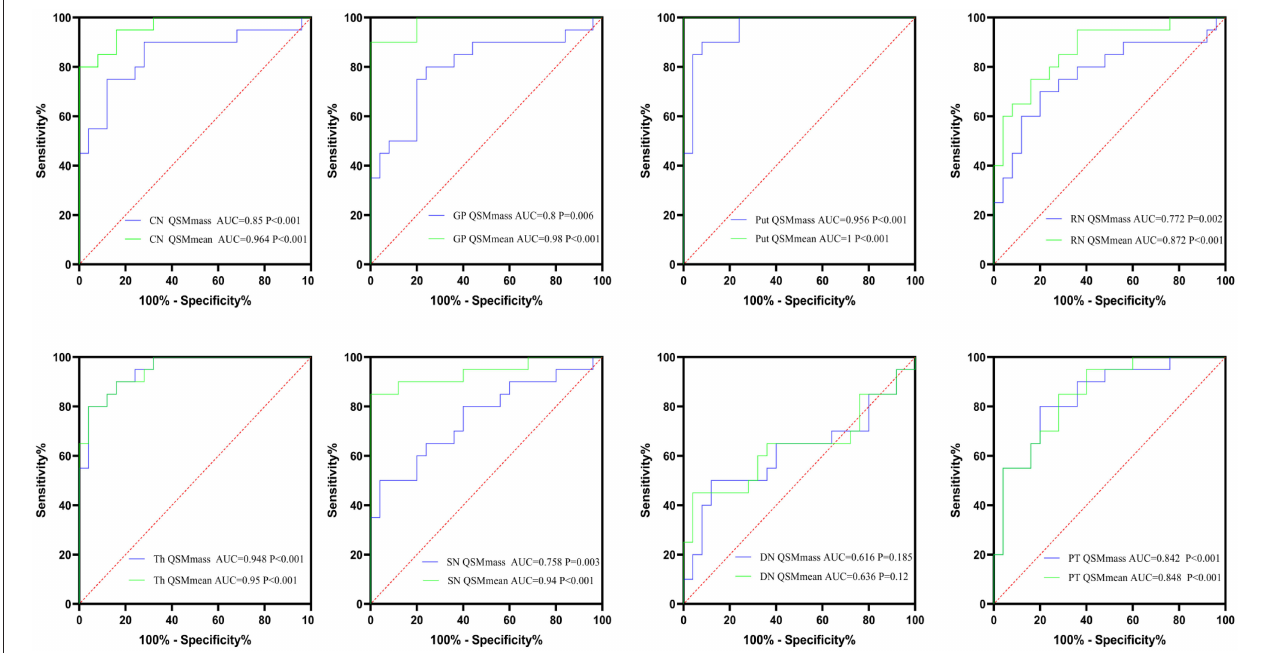
FIGURE 6 | The results of ROC curve analyses of mean bulk susceptibility and total susceptibility between neuro-WD and HCs. CN, head of the caudate nucleus; DN, dentate nucleus; GP, globus pallidus; Put, putamen; RN, red nucleus; SN, substantia nigra; Th, thalamus; PT, pontine tegmentum.